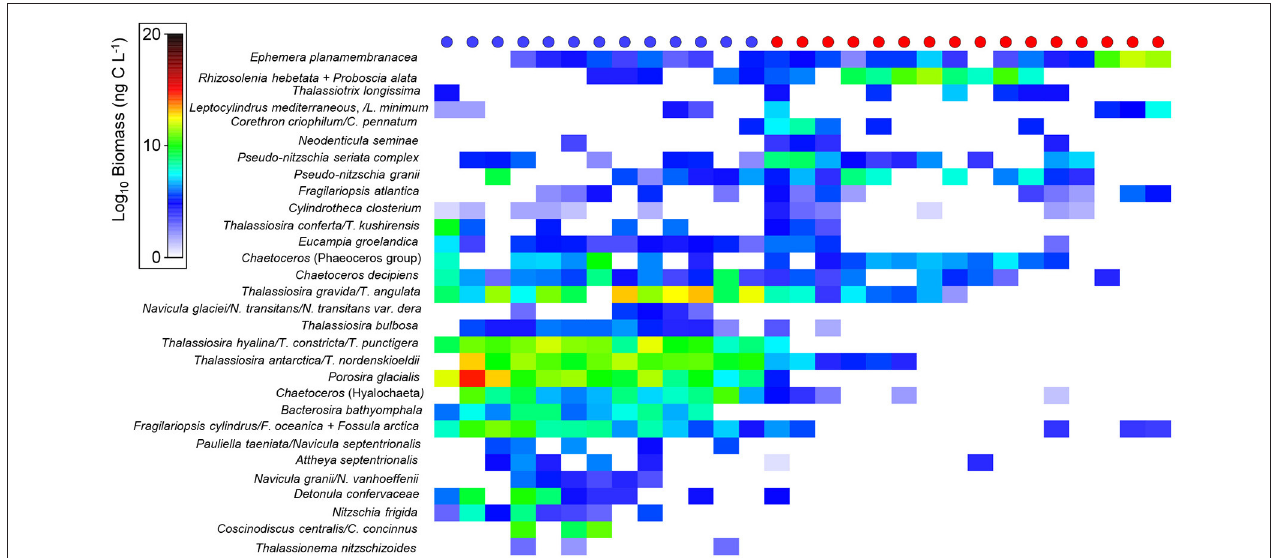
FIGURE 5 | Biomass (ng C L − 1 ) (after log-transformation) of diatom species found in stations (circles at the top) categorised as Arctic- (blue) or Atlantic-influenced